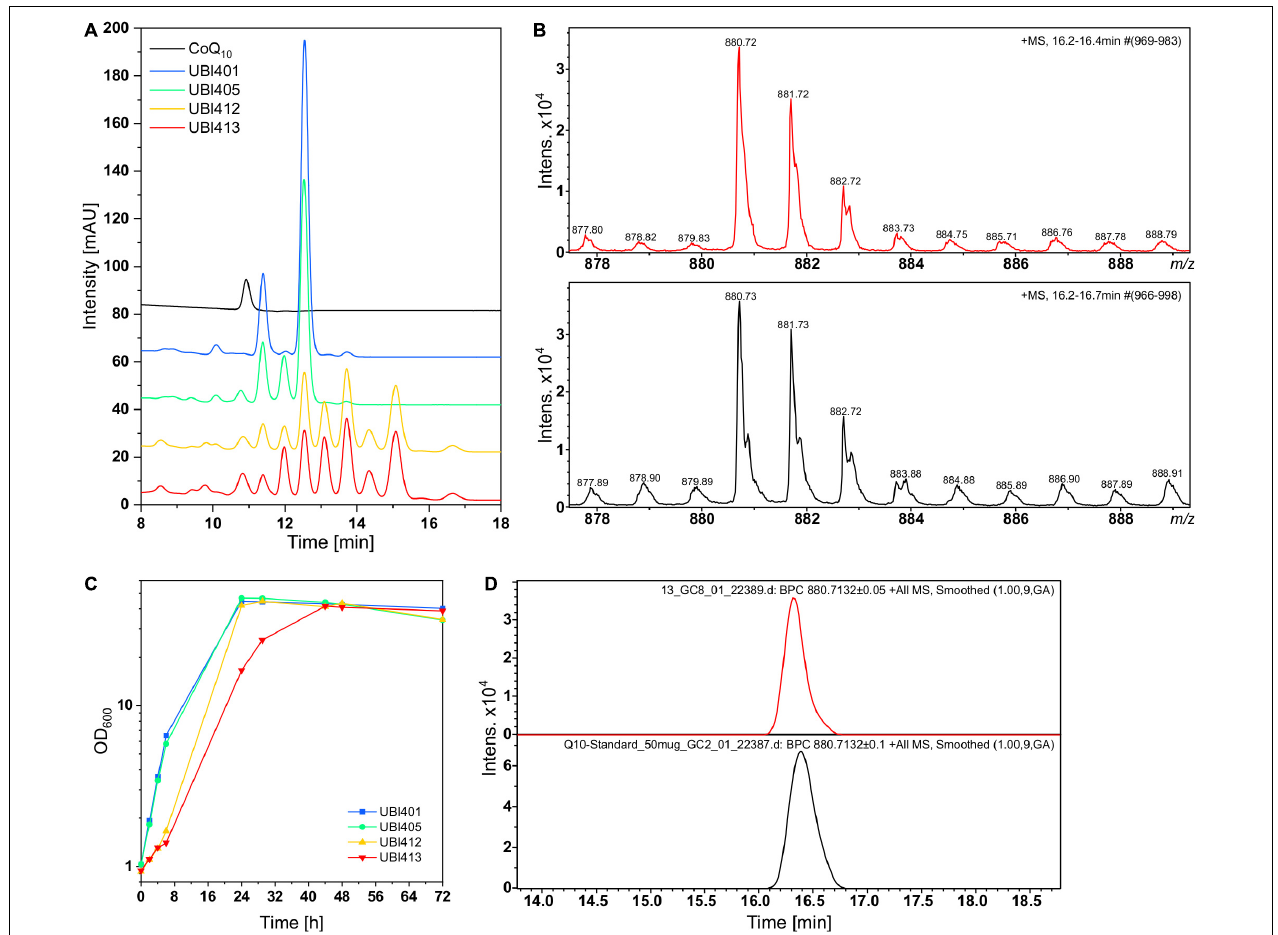
FIGURE 7 | High performance liquid chromatography (HPLC) and LC-MS analyses of quinone extracts from different UBI strains for CoQ10 detection. (A) Overlaid chromatograms of the CoQ10 standard and UBI strains with UBI413 (red) carrying the vectors pRG_Duet2- ddsA-ubiA , pEC-XT99A- ubiDIBX , and pEKEx3- ubiGHEF to facilitate CoQ10 production. (B) Isotope pattern of CoQ10 from quinone extract of UBI413 (red) and from the CoQ10 standard (black). (C) Growth curves of strains that were used for quinone extraction. (D) Base peak chromatogram of m/z 880.71, the ammonium adduct mass of CoQ10 in the quinone extract of UBI413 (red) and in the CoQ10 standard